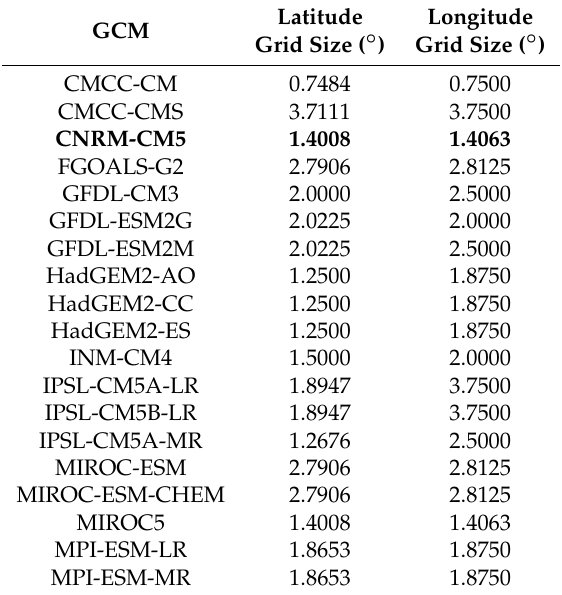
Table 1. List of general circulation models (GCM) employed. The GCM CNRM-CM5 is used to build the non-stationary statistical model, whereas the other GCMs are compared to CNRM-CM5. CNRM-CM5 is shown in boldface to ease its search in the list. Latitude Longitude GCM Grid Size ( ◦ ) Grid Size ( ◦ ) CMCC-CM 0.7484 0.7500 CMCC-CMS 3.7111 3.7500 CNRM-CM5